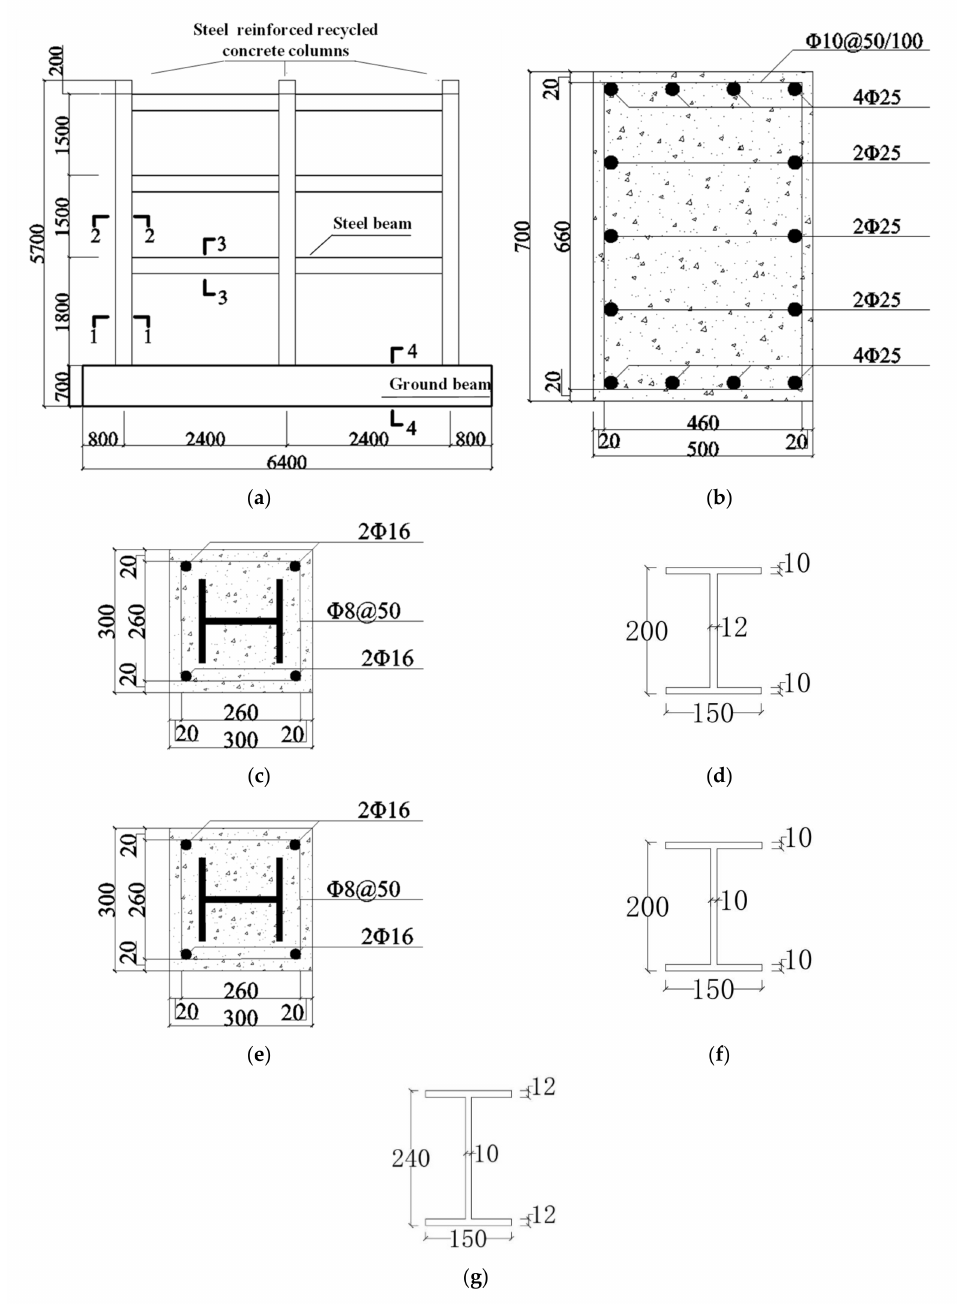
Figure 1. Specimen size and section details. ( a ) Specimen size; ( b ) 4-4 Cross section; ( c ) 1-1 Cross section; ( d ) 1-1 Section steel; ( e ) 2-2 Cross section; ( f ) 2-2 Section steel; ( g ) 3-3 Cross